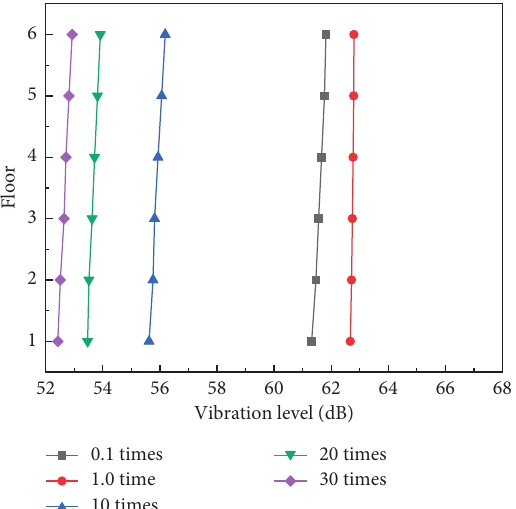
Figure 10: Variation curve of building vibration with floor under different soil elastic